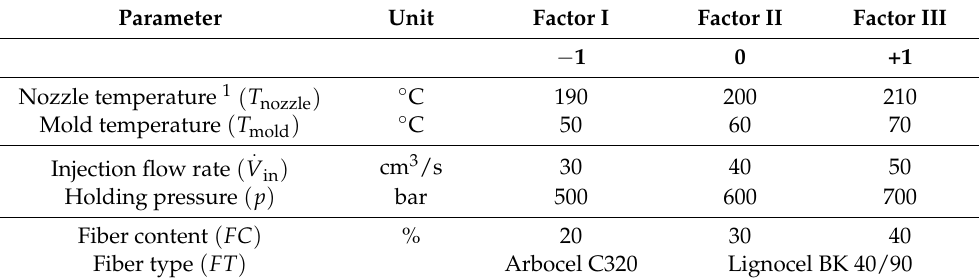
Figure 2. Test specimens of wood ‐ filled TPU. Top: TPU with 30 ‐ wt ‐ % Lignocel BK40/90, bottom: 30 ‐ wt ‐ % Arbocel C320. Table 1. Parameters for the experimental setup. The parameters were varied in factor levels